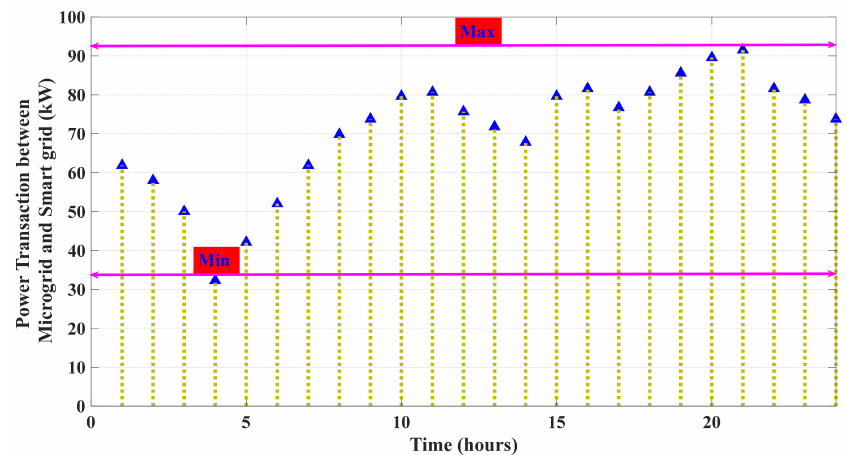
Figure 7. The power exchanging between microgrid and the smart grid.